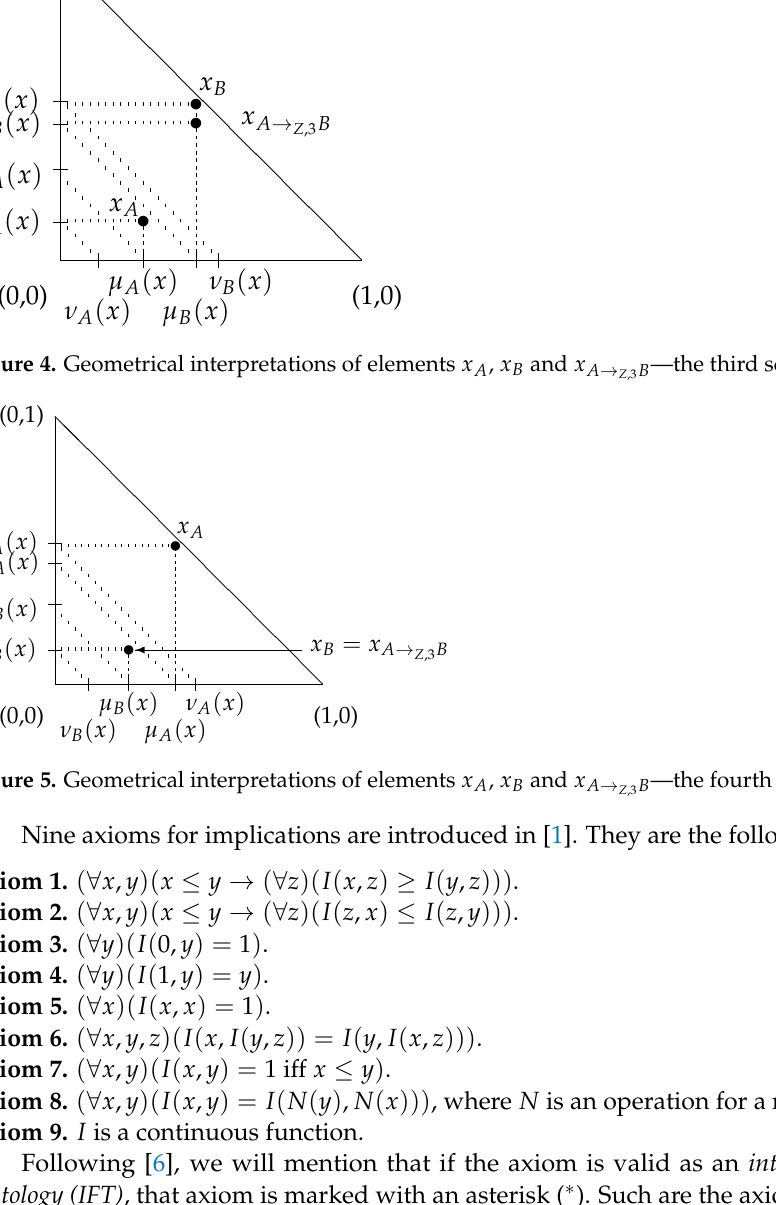
, x B and x – the second scenario A A B B – the second scenario 47 → Z ,3 → Z ,3 B – the second scenario 47 → Z ,3